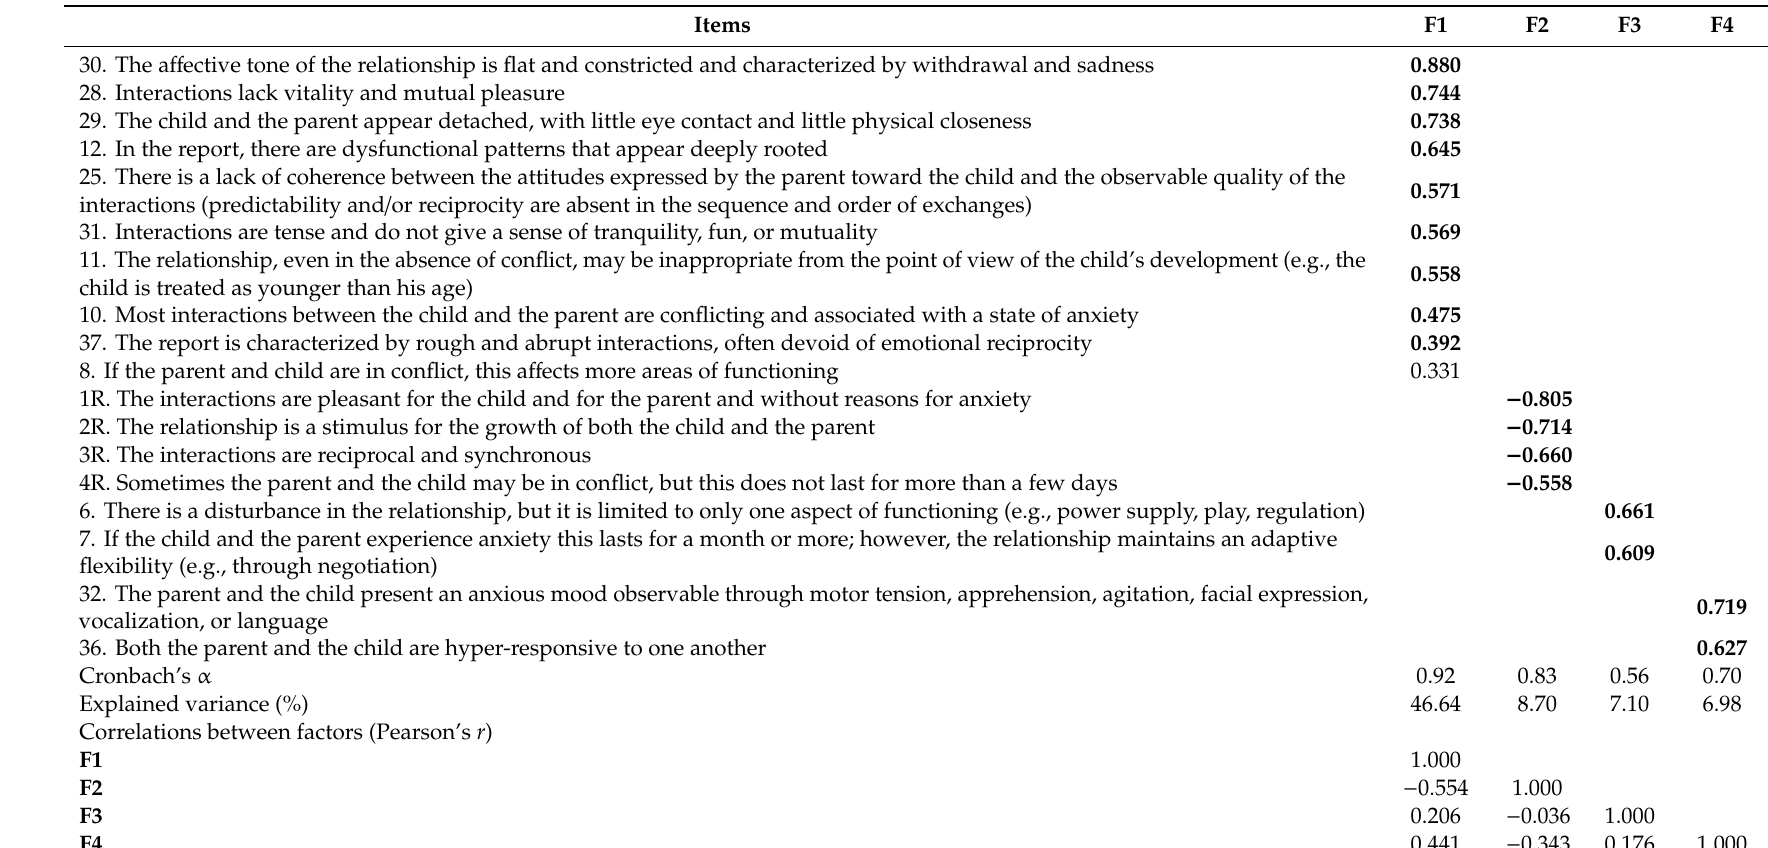
Table 1. “Interaction” Area Exploratory Factor Analysis and Correlation Matrix Between